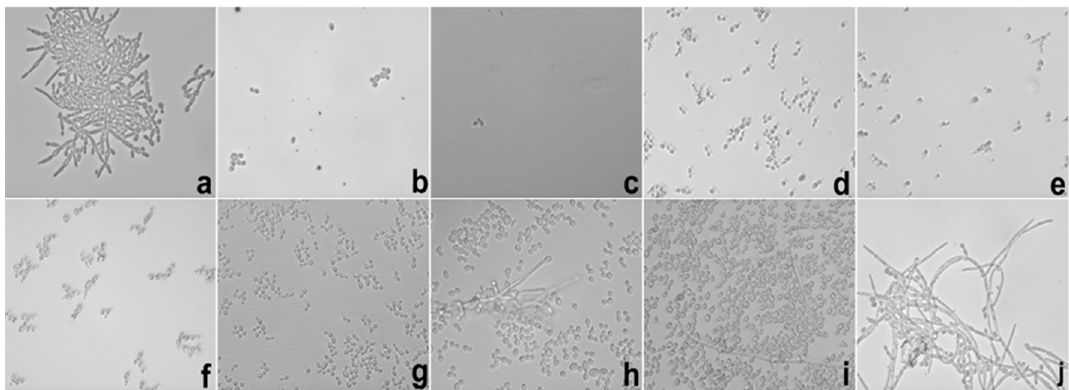
Figure 7. Photomicrography of 12 h of the hyphae inhibition test of C. albicans realized with SE. Legend: ( a ) growth control; ( b ) amphotericin B 16 μ g/mL; ( c – j ) SE from 1000 to 7.8 μ g/mL in descending order. SE = Formulation with extract.